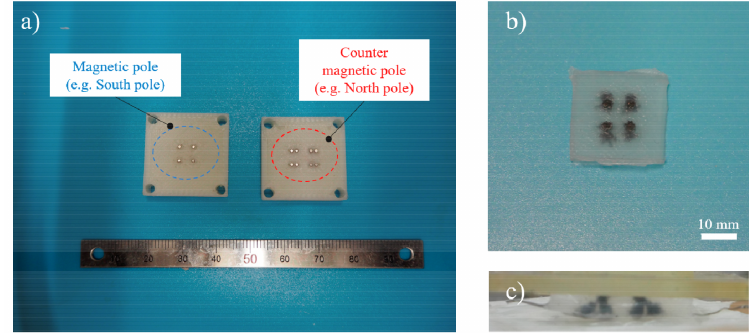
Figure 10. Arrayed soft-MPS: ( a ) mold for soft-MPS array; ( b ) picture of soft-MPS array (top view); ( c ) picture of soft-MPS array (side